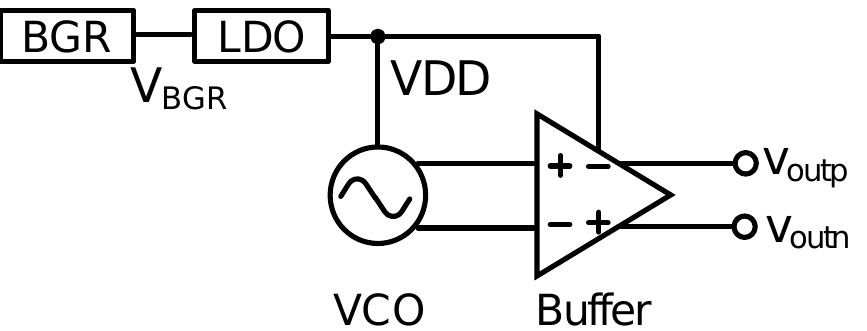
Figure 1. Proposed architecture: voltage-controlled oscillator (VCO) with a varactor-only capacitor array, on-chip bias (bandgap reference and low drop-out regulator), and 50 Ω terminated shunt- feedback buffer.